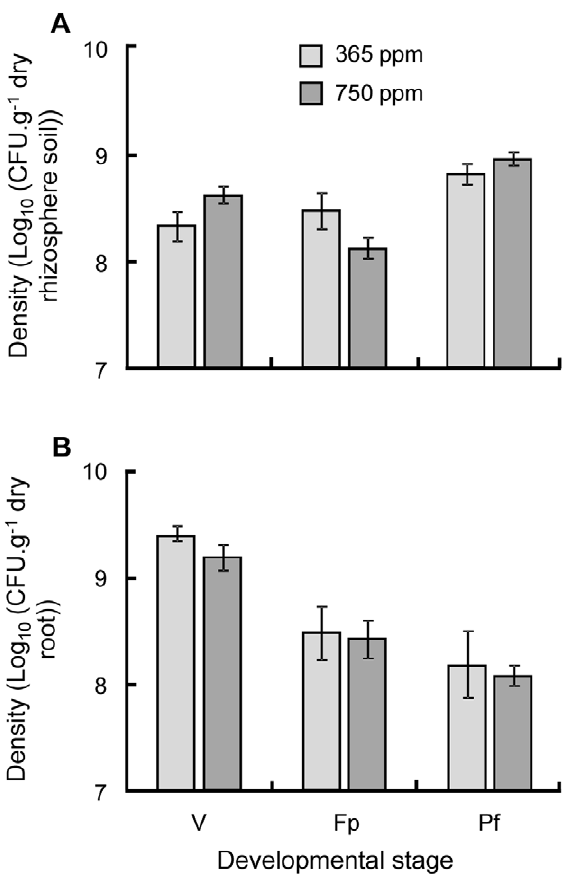
Figure 6. Average density of Pseudomonasfluorescens C7R12 over time. The density of the bacterial strain was measured for the developmental stages chosen (V: vegetative; Fp: Flowers, some pods; Pf: Pods, some flowers) in compartments (A) rhizosphere soil and (B) root. Data were log-transformed to achieve normality and equal variances respectively tested by Shapiro-Wilk and Bartlett tests. The densities of microorganisms were analysed with ANOVA using as explanatory fixed factors the developmental stage and CO 2 concentration and their interactions, nested within the replicate experiment factor. Standard errors are represented by vertical